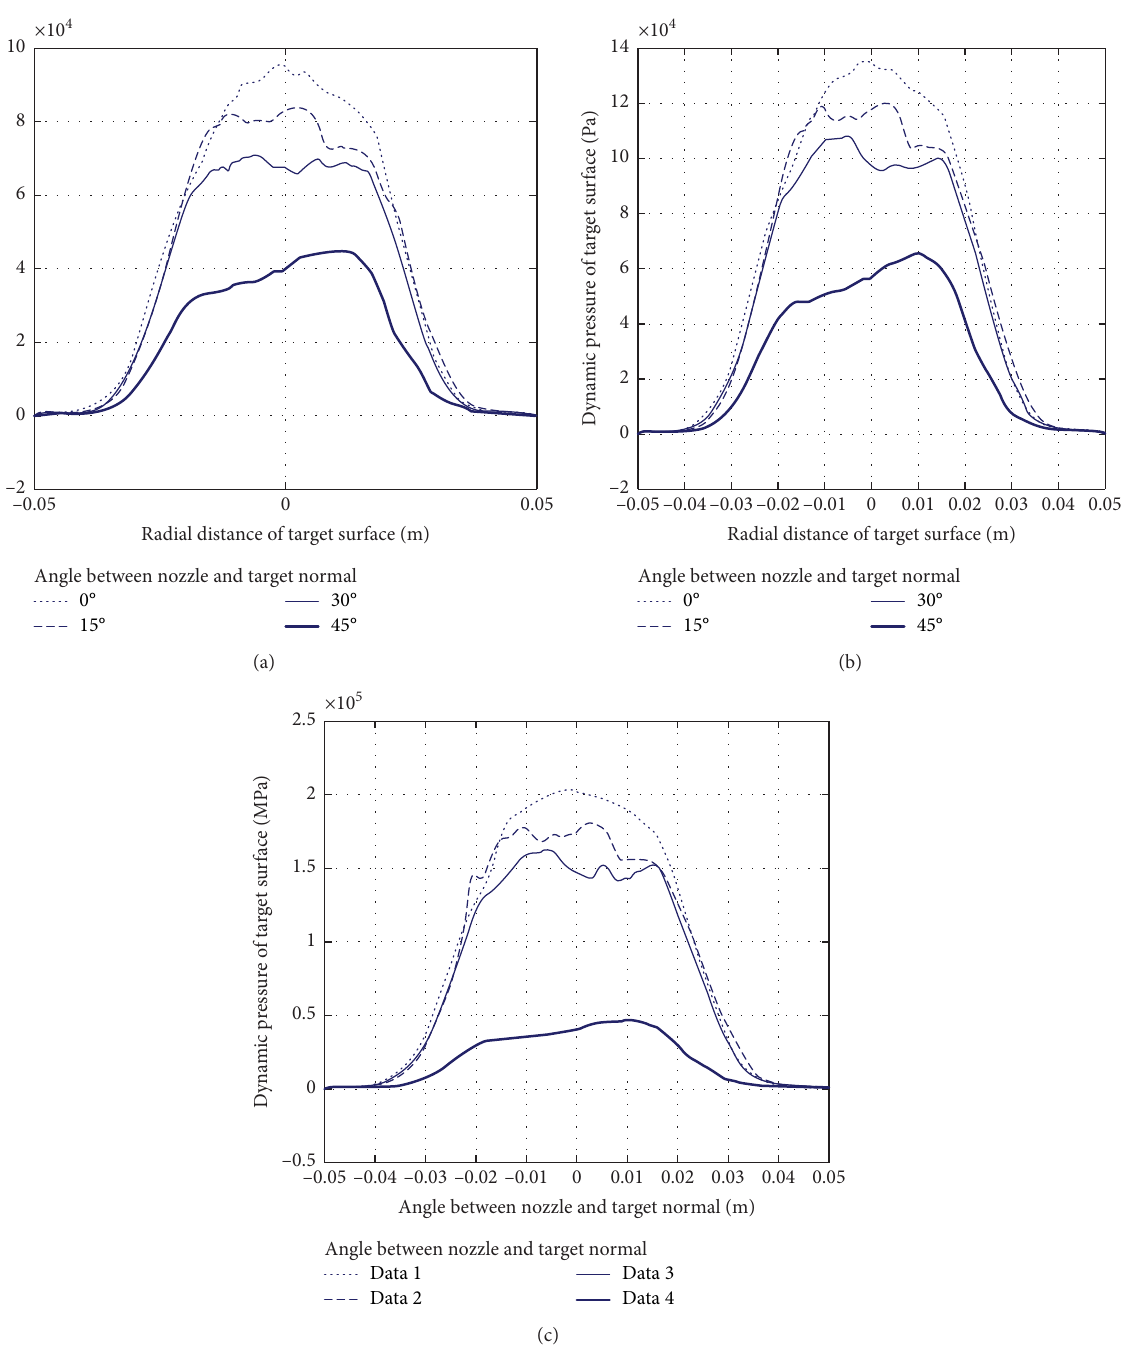
Figure 12: Radial dynamic pressure curves of target surface at different angles. (a) Interpressure 7 MPa. (b) Interpressure 10MPa. (c) Interpressure